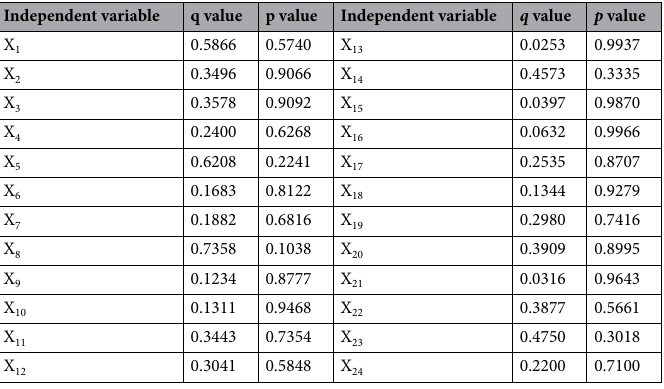
Table 4. Results of factor